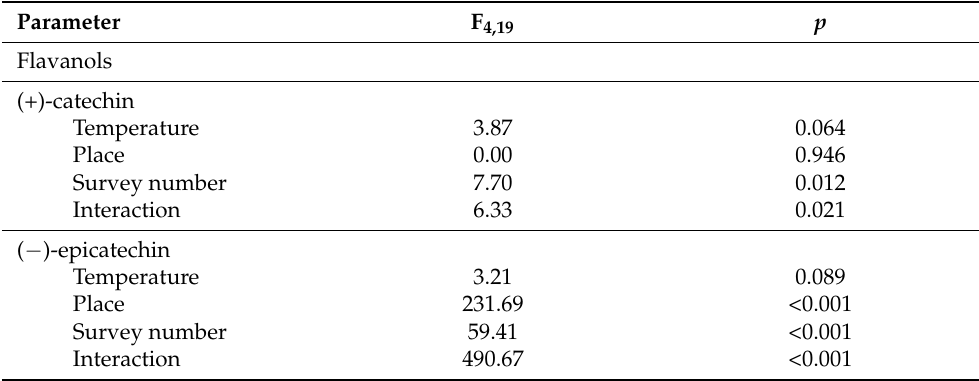
Table 4. The effects of temperature, place, survey number and interaction between studied parameters on level of flavanols in V. opulus (GLM, normal error